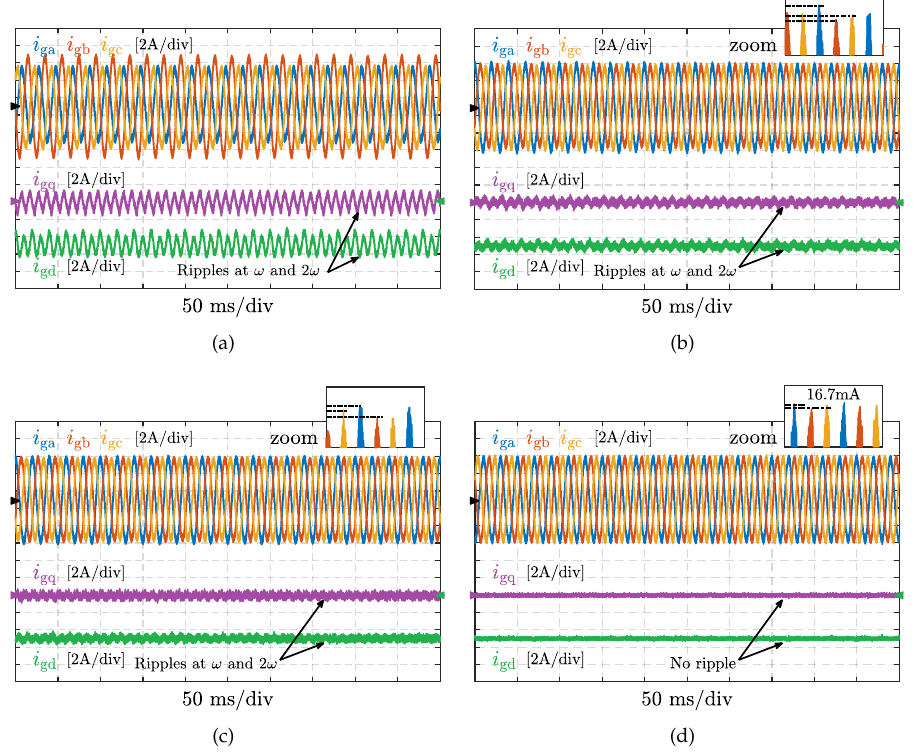
Figure 11. Experimental results under voltage measurement errors: ( a ) Traditional controllers without additional compensation schemes; ( b ) The conventional compensation scheme based on MRSCs; ( c ) The conventional compensation scheme based on the plug-in RC; ( d ) The proposed dual-loop